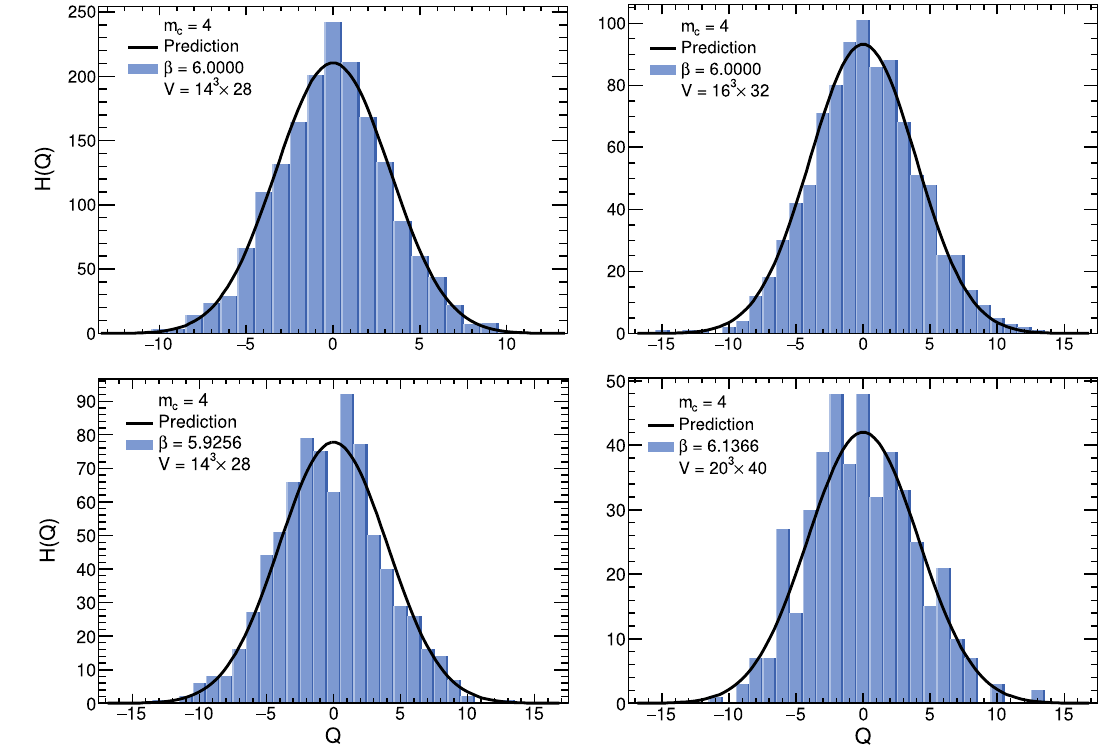
Fig. 9 The histograms H( Q ) of the topological charges Q . The mag- netic charges are m c = 4. The lattices are β = 6 . 0000 , V = 14 3 × 28 (upper left), β = 5 . 9256 , V = 14 3 × 28 (lower left), β = 6 . 0000 ,